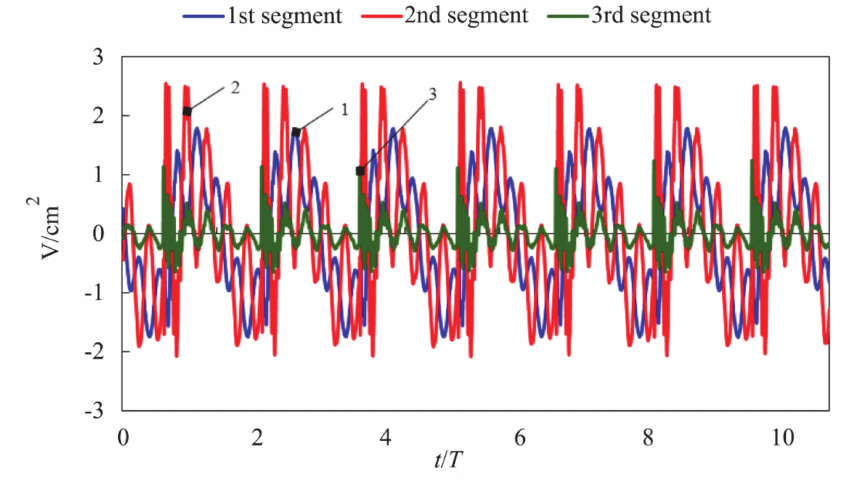
Figure 8. Measured open-circuit harvested voltages for the MFC-magnet energy harvester